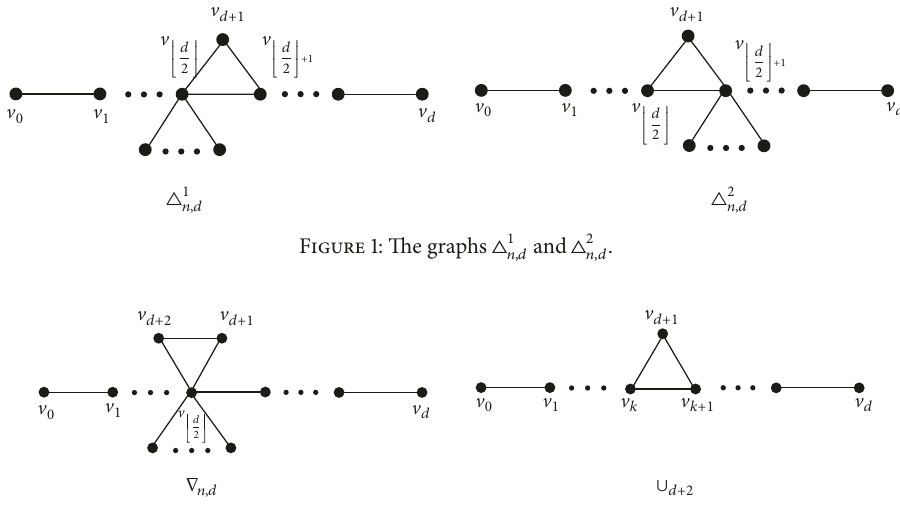
Figure 1: The graphs 󳵻 1 𝑛,𝑑 and 󳵻 2 𝑛,𝑑 .